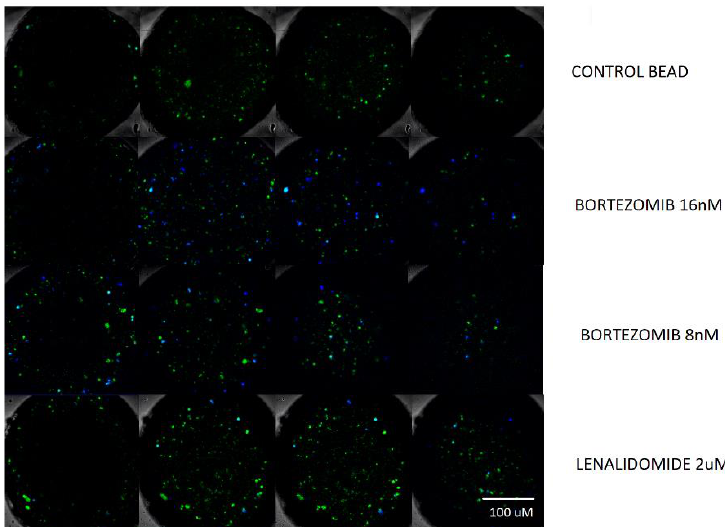
Figure 6. Confocal microscopy imaging of 4 different z planes for beads marked using FITC CD38 (green) and DAPI (blue). Z planes were chosen to image the maximum number of cells. From top to bottom: control bead, bead incubated with bortezomib 16 nM, bead incubated with bortezomib 8 nM and bead incubated with lenalidomide 2 uM.